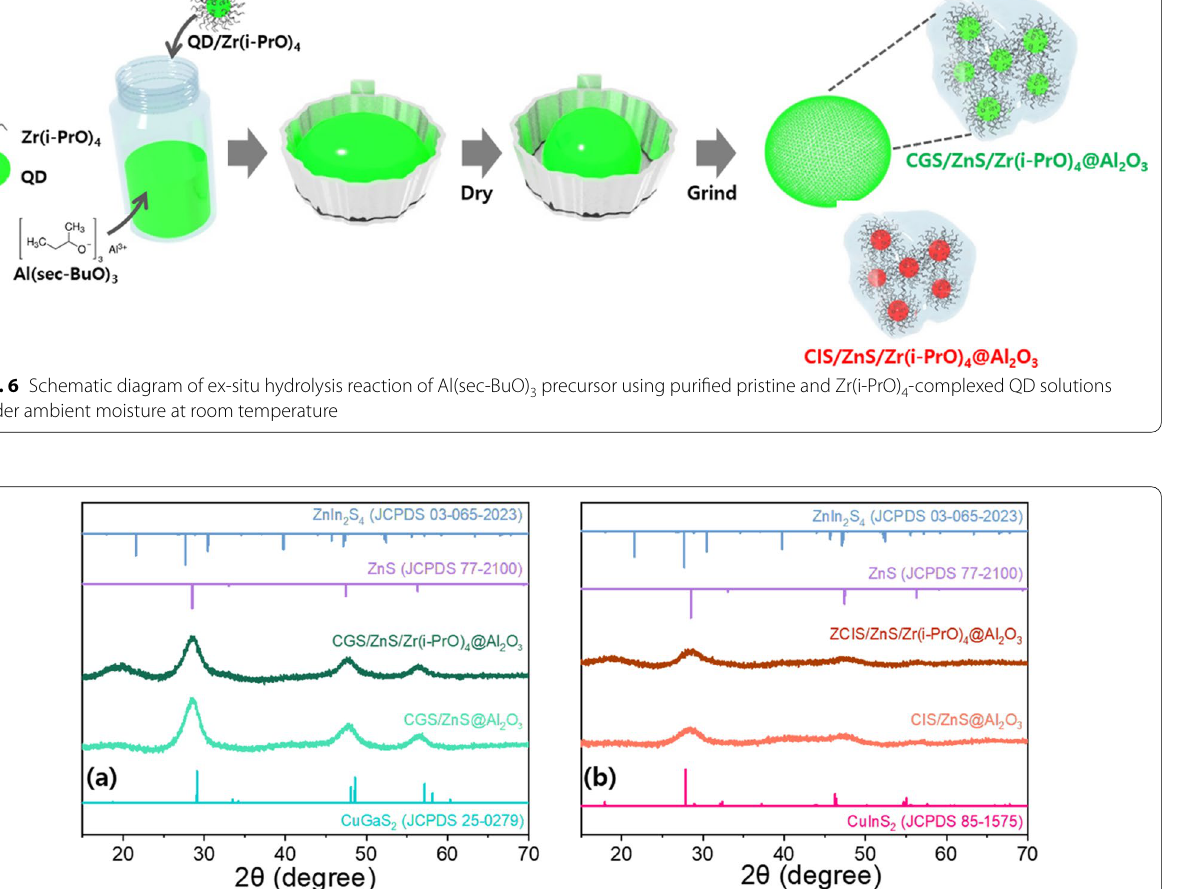
Fig. 7 XRD patterns of final Al 2 O 3 encapsulated a green CGS/ZnS based and b red CIS/ZnS based powder